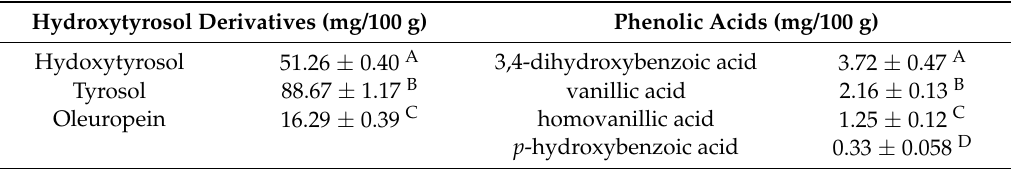
Table 1. Contents of main phenolic compounds in